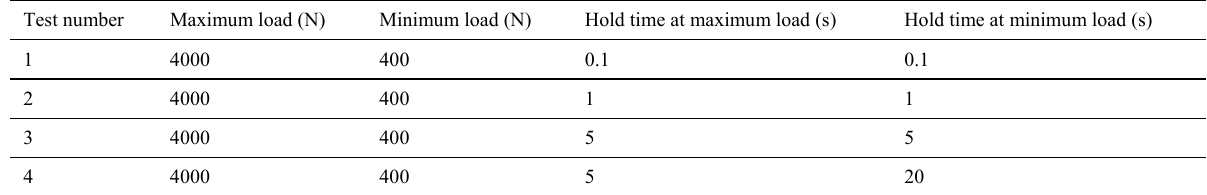
Table 1: fatigue tests